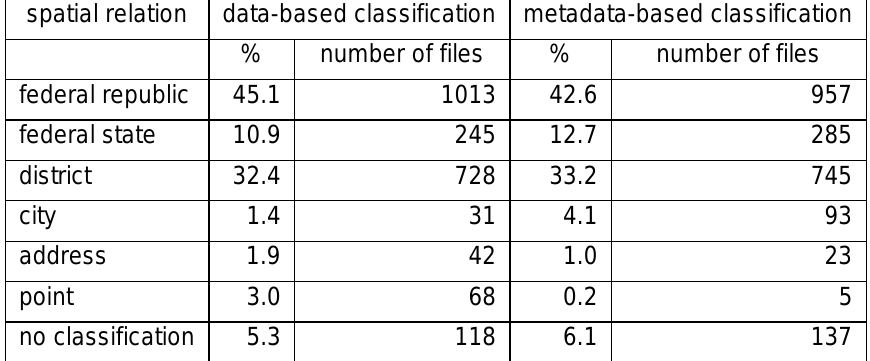
Table 1: Results of the classification of the CSV data mining software for the metadata and the actual data in the CSV files. The percentages are rounded. The data-based and metadata-based classifications overlap largely. 87% of classified datasets are in the same classes in both